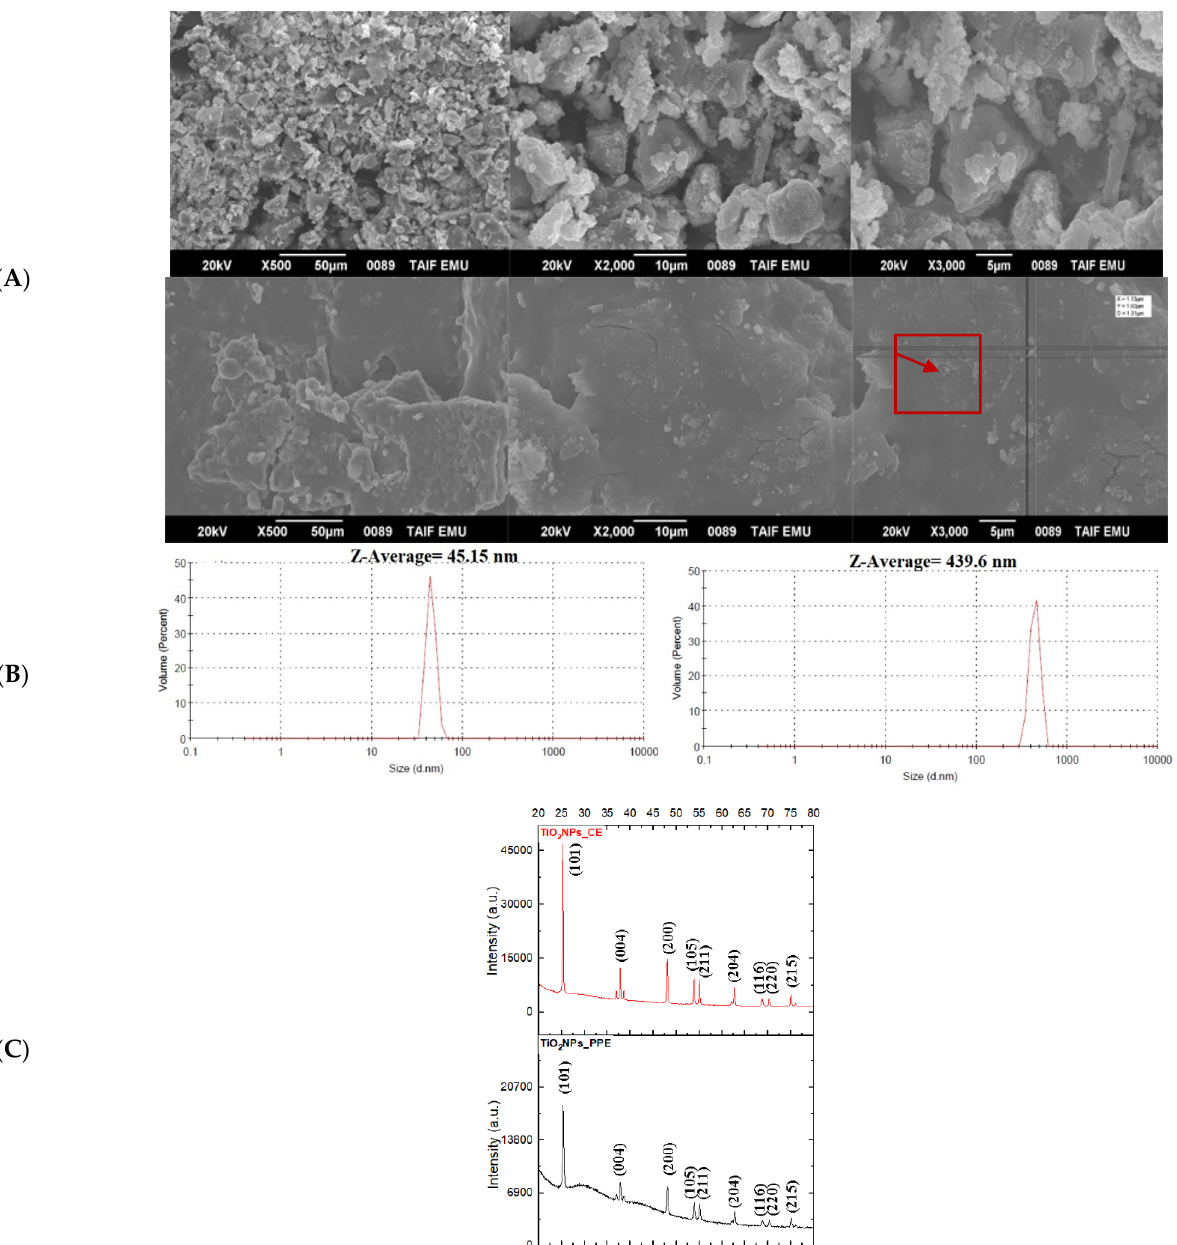
Figure 2. Size and shape properties of synthesized TiO 2 NPs: ( A ) amorphous and crystalline shape showed by SEM image at different magnifications (Red box and arrow indicate the synthesized nanoparticles). ( B ) The average size revealed by Zeta potential analyzer and ( C ) anatase crystalline shape by XRD pattern, of TiO 2 NPs_CE and TiO 2 NPs_PPE.